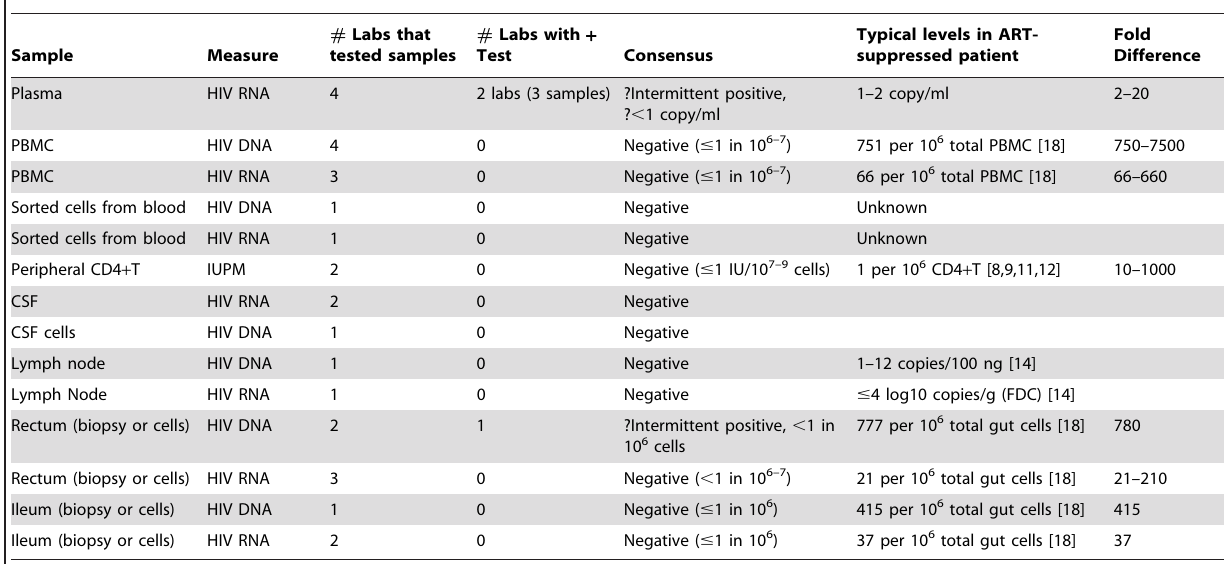
Table 4. Summary of virologic measures.